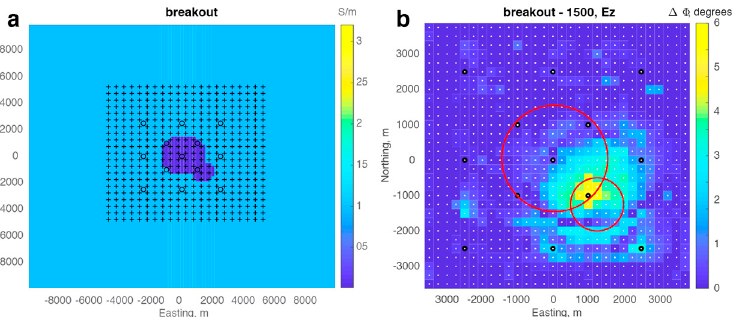
show where the changes have occurred in the reservoir.